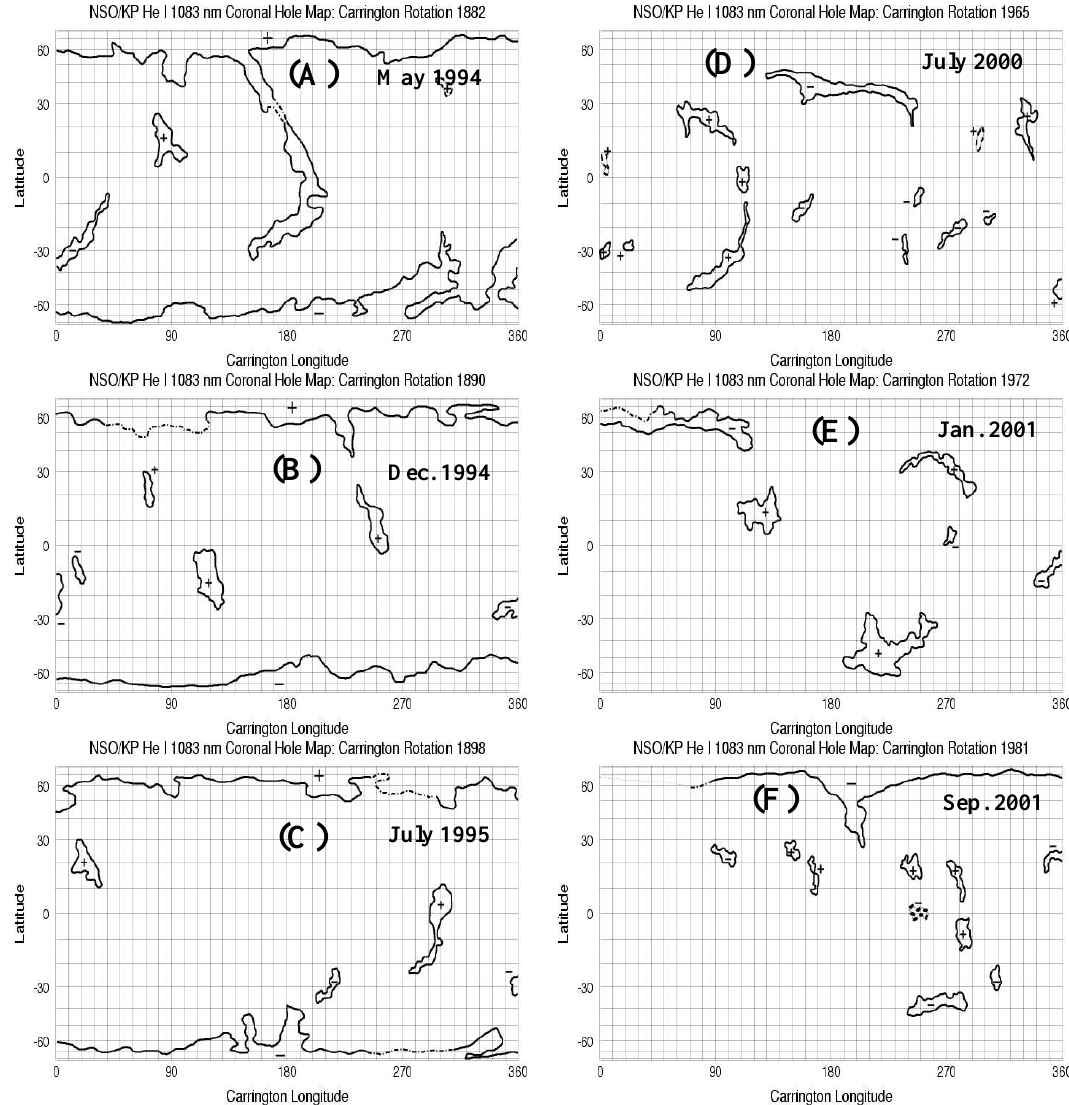
Fig. 11. Coronal holes by Carrington rotation number as inferred from 1083 nm He I observations made at Kitt Peak for the first (left) and second (right) fast latitude